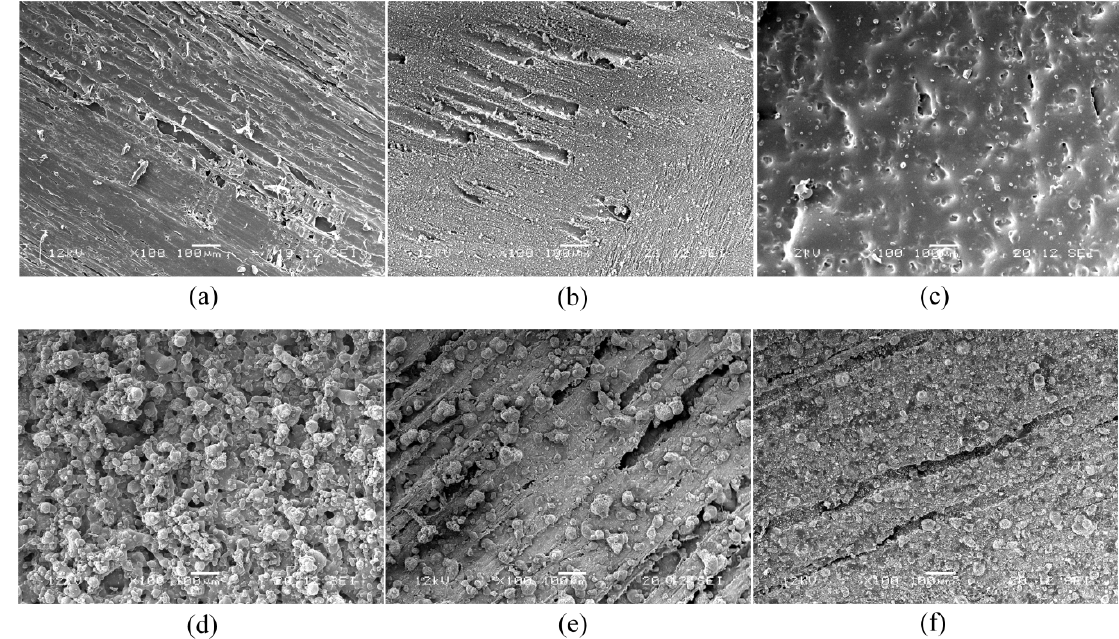
Figure 2. SEM-images with a magnification of 100× (scale bar 100 μ m): ( a ) uncoated wood beech; ( b ) TiO 2 film; ( c ) polyester thick film; ( d ) polyester / TiO 2 thick film; ( e ) polyester / TiO 2 thin film; ( f ) ( b ) TiO 2 film; ( c ) polyester thick film; ( d ) polyester/TiO 2 thick film; ( e ) polyester/TiO 2 thin film; polyester / TiO 2 film via ( f ) polyester/TiO 2 film via (PSP).